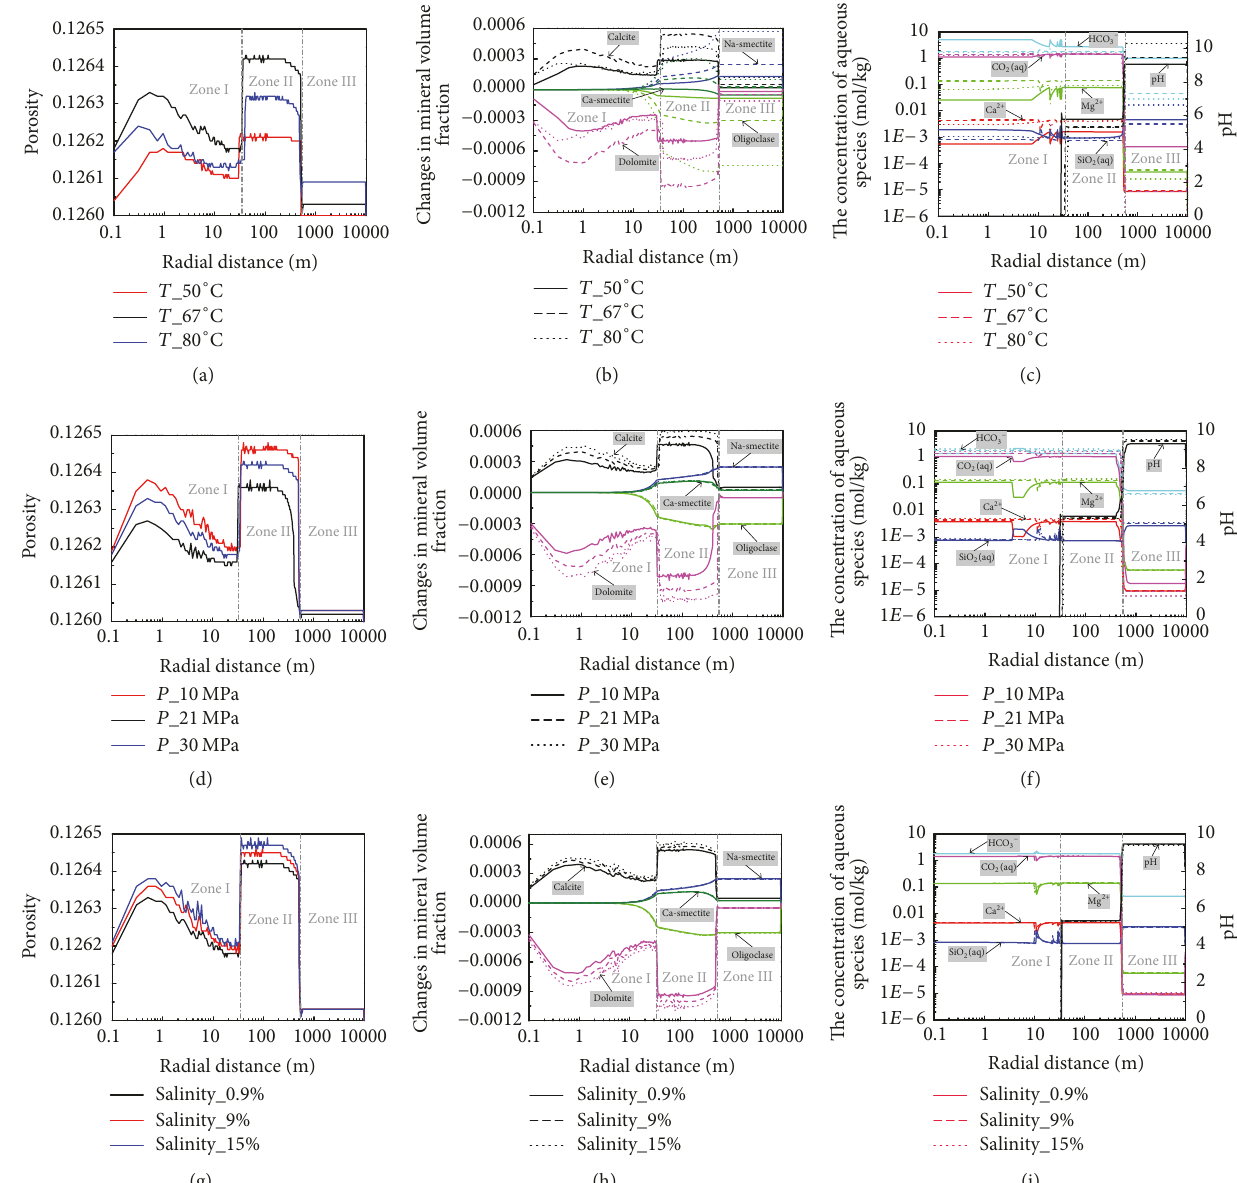
Figure 5: The horizontal distribution of changes in porosity, mineral volume fraction, and concentrations of major aqueous species and pH for different temperature (a, b, and c), pressure (d, e, and f), and salinity (g, h, and i).